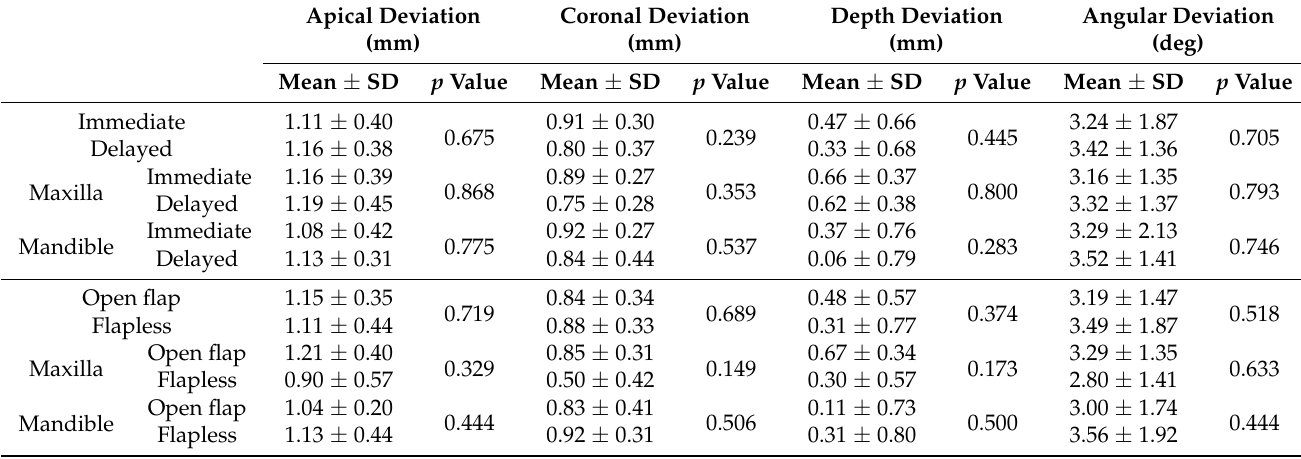
Table 6. t -Test specific to the influence of timing of implant placement and surgical technique on the deviation values (N = 52). Apical